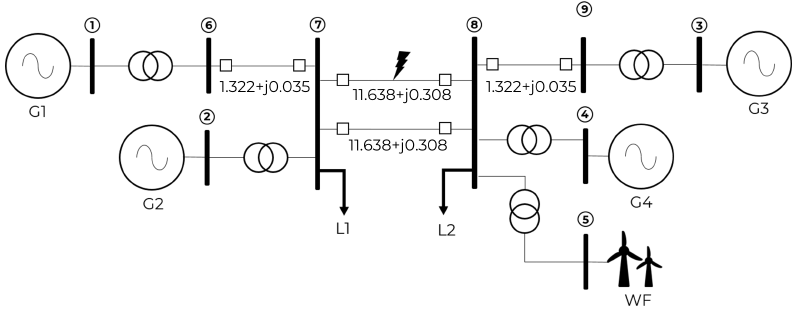
Figure 3. Modified two-area Kundur